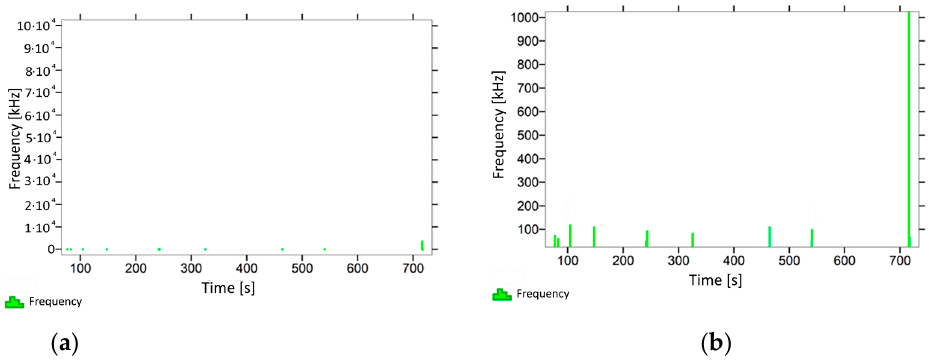
Figure 14. Graph of frequency distribution during the test for a representative sample from series P 13 : ( a ) considering the entire occurring frequency range and ( b ) with details about the frequency range before the moment of breakage.